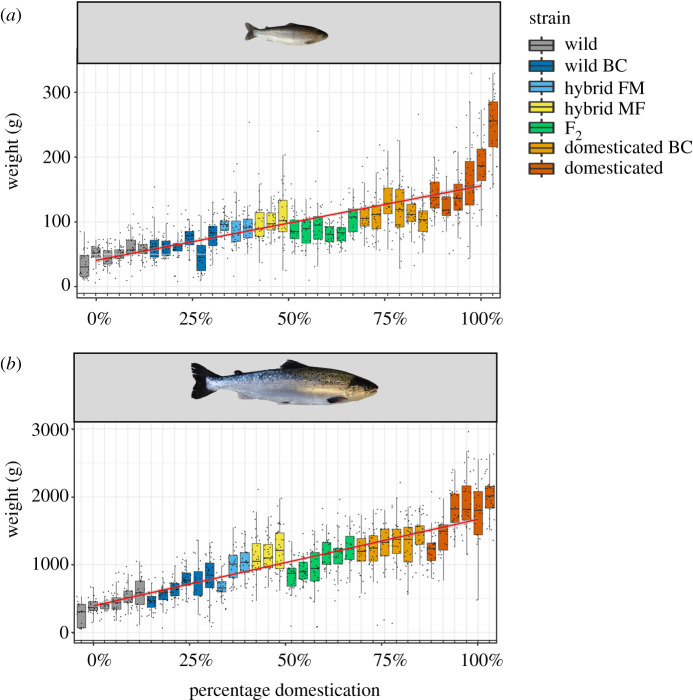
Boxplots of wet weight in grams between both (a) freshwater and (b) saltwater individuals, further broken down into the families that make up the seven experimental strains (wild, wild backcross (wild BC), hybrid FM (Figgjo (♀) × Mowi (♂)), hybrid MF (Mowi (♀) × Figgjo (♂)), F2 hybrids, domesticated backcross (domesticated BC) and domesticated (Mowi)), as shown by the different colours. Additionally to the boxplots of wet weight per family, there is also a linear regression, as shown in red, that was run between the percentage levels of domestication, including 0% (wild), 25% (wild BC), 50% (F1 and F2 hybrids), 75% (domesticated BC) and 100% (domesticated). Percentage level of domestication used here is calibrated to our experimental design, with our domesticated strain being 100% domesticated, and our wild strain being 0% domesticated. Intermediate levels of domestication are produced through different combinations of hybridization, be it direct hybrids (50% domesticated, 50% wild), wild backcrosses (25% domesticated, 75% wild) or domesticated backcrosses (75% domesticated, 25% wild).